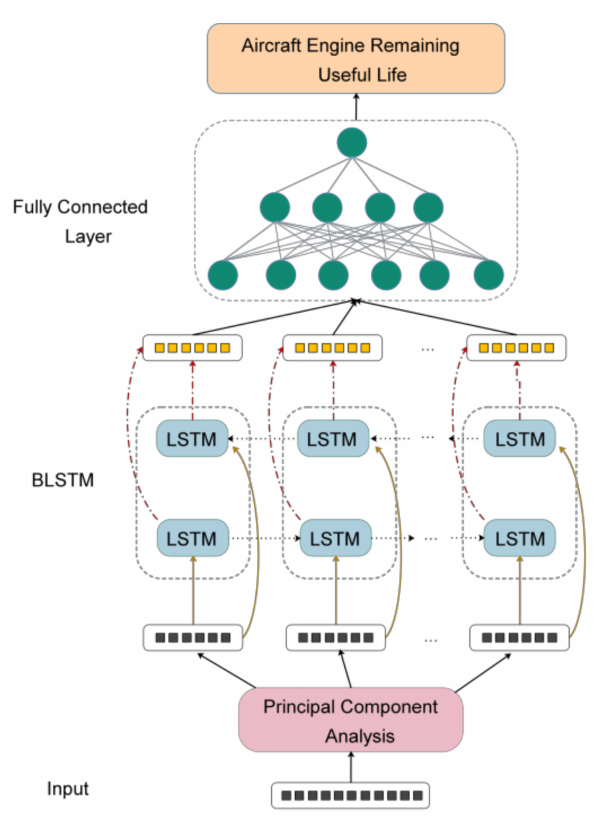
Figure 3. Structure diagram of the principal component analysis (PCA)–BLSTM hybrid model.